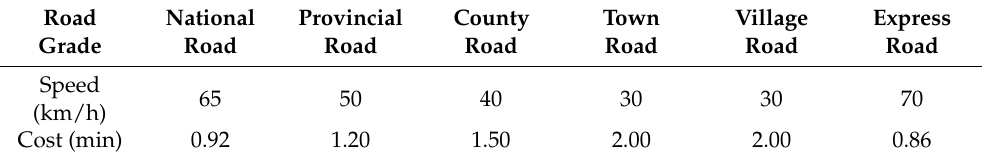
Table 6. Travel time cost of the road networks in Nyingchi.